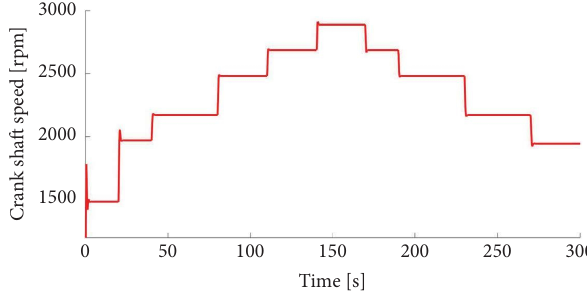
Figure 3: Crank shaft speed of the IC engine.